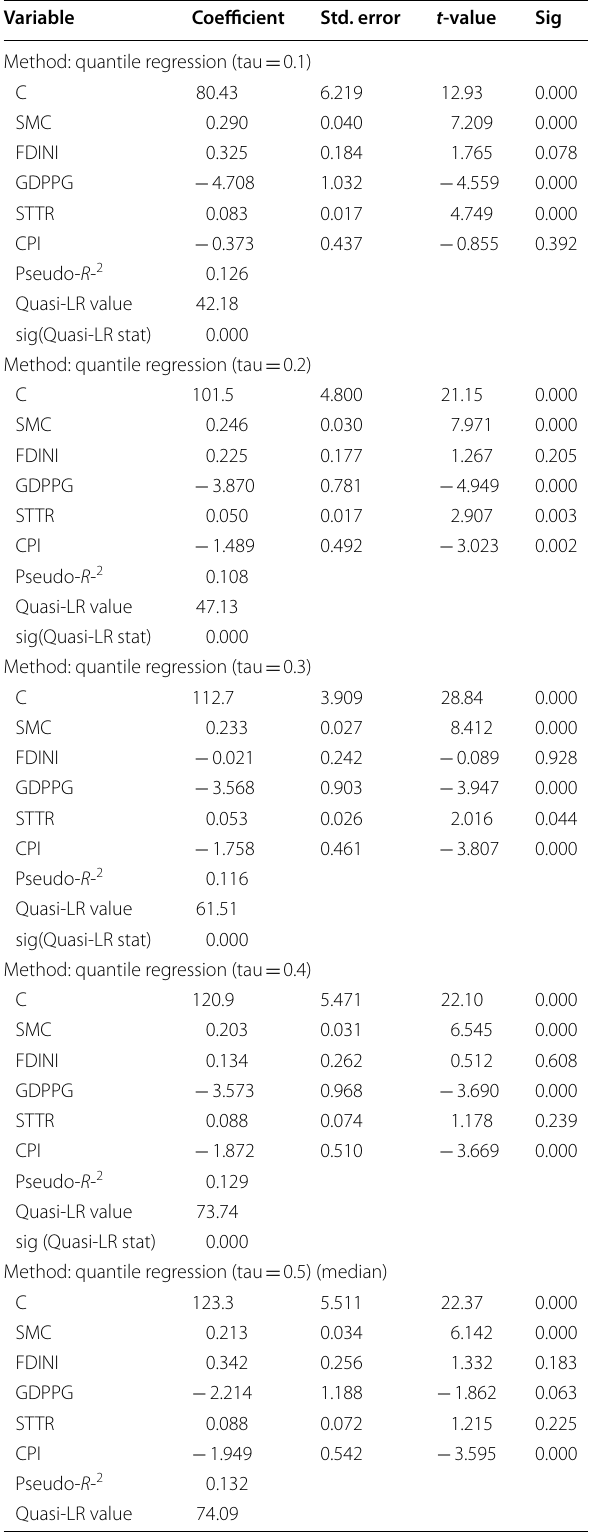
Table 10 Quantile Regression (tau Software of E-views 10